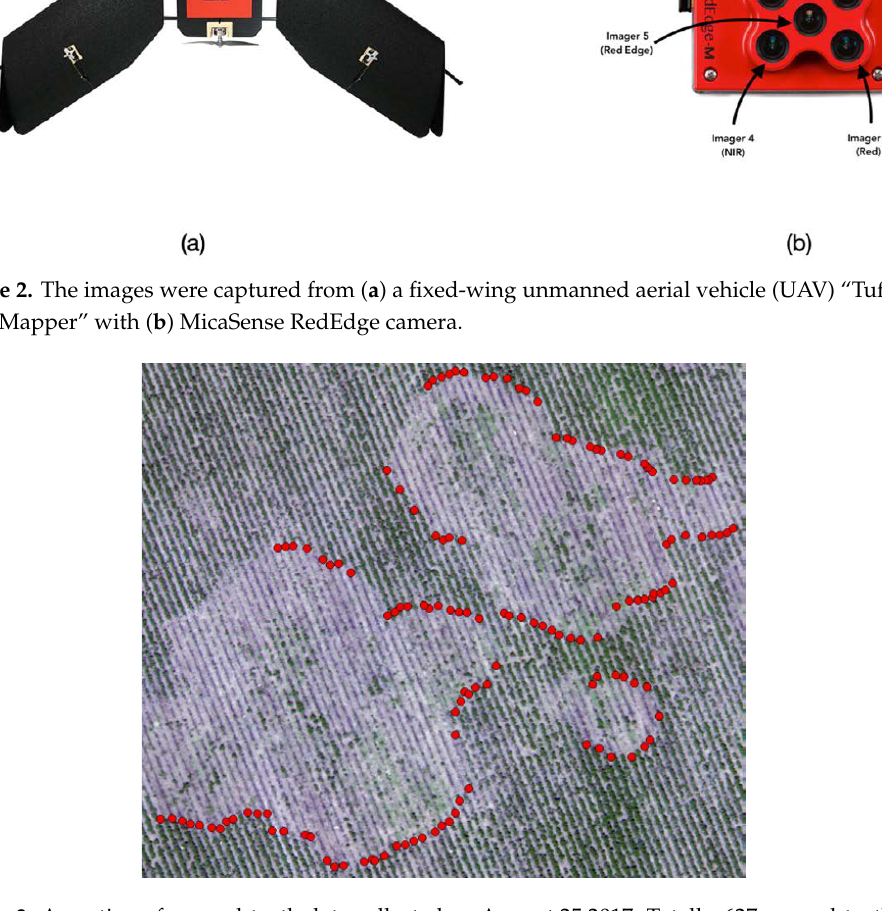
Figure 3. A portion of ground-truth data collected on August 25 2017. Totally, 627 ground-truth data points (in red) were recorded to delineate the boundary of some cotton root rot (CRR)-infested zones.